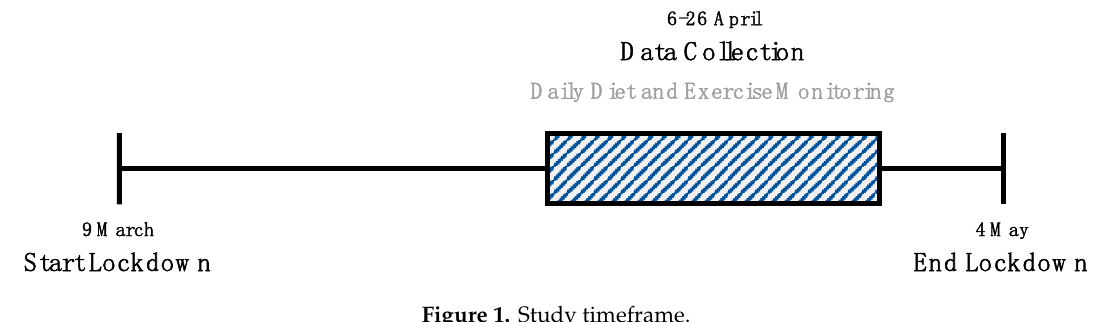
Figure 1. Study Figure 1. Study timeframe.